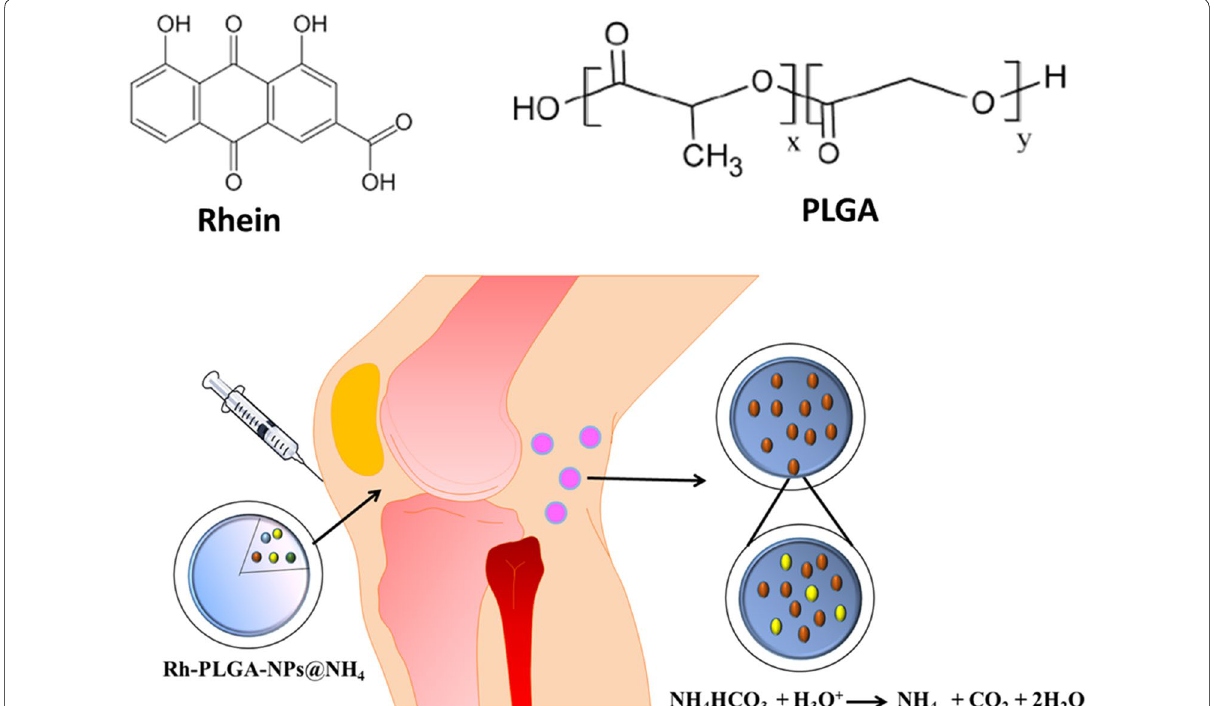
Fig. 1 Schematic illustration of pH-responsive Rh-PLGA-NPs@NH 4 used for the treatment of